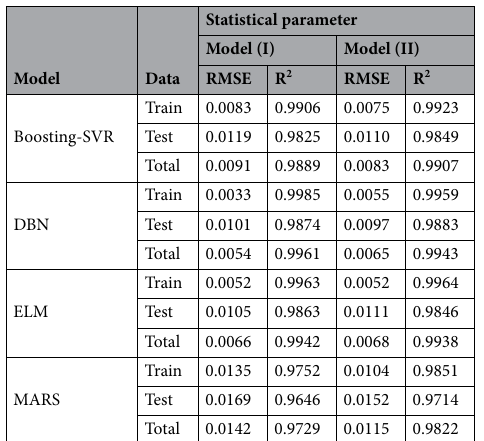
Table 5. Statistical analysis results of developed